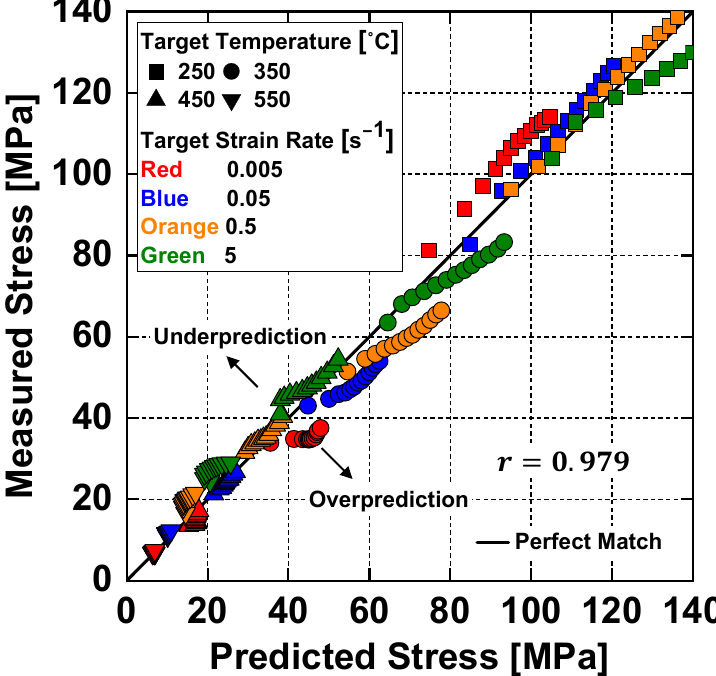
Figure 4. Temperature-dependent compressive yield stress of Al 6063 alloy at target strain rates of: ( a ) 0.005 s − 1 ; ( b ) 0.05 s − 1 ; ( c ) 0.5 s − 1 ; and ( d ) 5 s − 1 . A scatter plot of the Pearson correlation coefficient is presented in Figure 5.